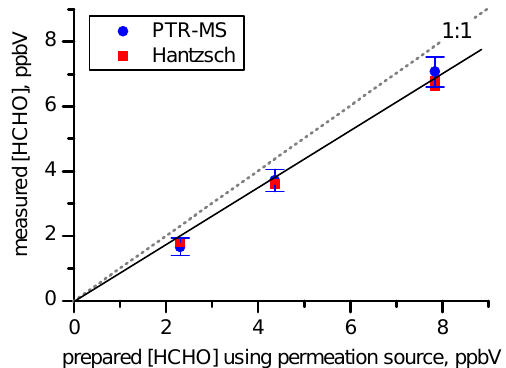
Fig. 3. Signal of m/z 37 (units are normalized counts ncps signal, i.e. m/z 37 normalized by m/z 21) as a function of sample air abso- lute humidity. Crosses represent field data. Solid green box cor- responds to synthetic air. The line is a second order regression fit Y = A + B1 × X + B2 × X 2 with the following parameters A=368, B1=1460, B2=11, with an R 2 =0.97. The insert describes the man- ner by which the H 2 O concentration in the drift tube is estimated for the dry sample air condition.